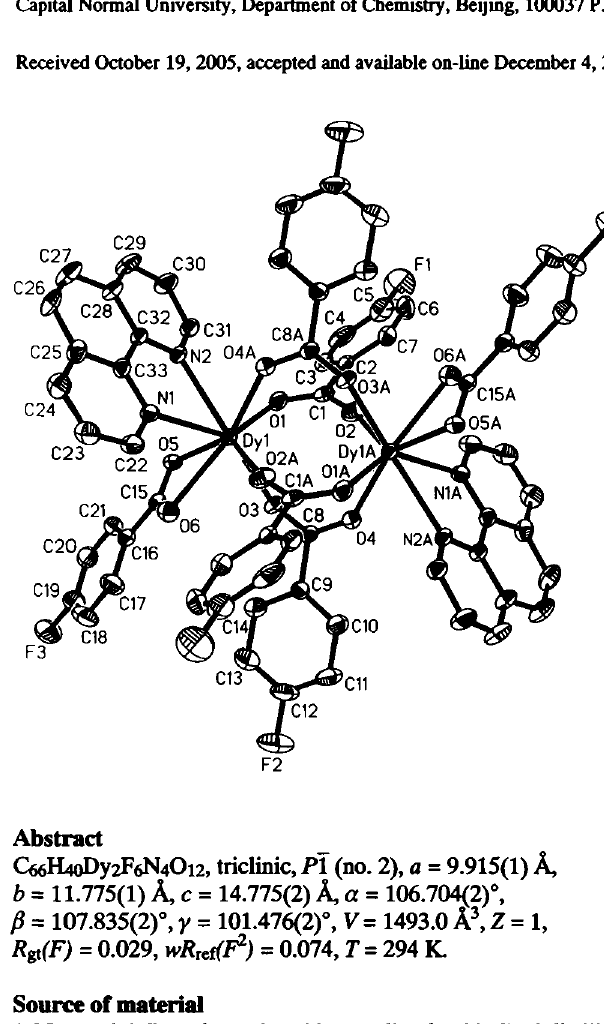
Table 1. Data collection and handling.